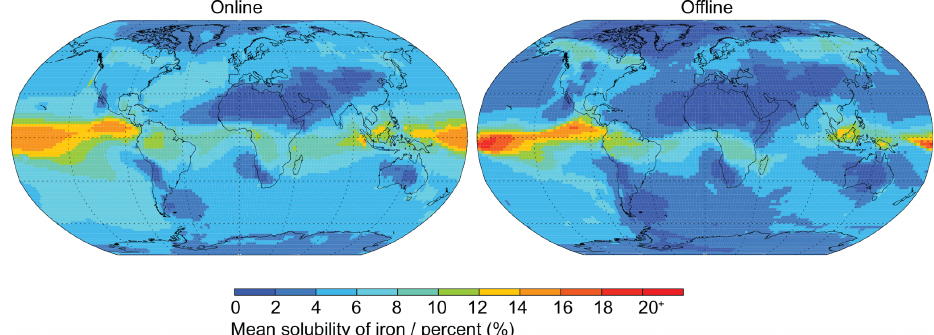
Figure 8. Mean solubility of iron when solubility is calculated at each 30min model time step (“online”) and when it is calculated from the post-processing of daily mean soluble and total iron concentration (“offline”). Table 7. Dust, fire, and anthropogenic combustion emissions of iron and relevant co-emitted aerosol emissions (to two significant figures). Multi-model emission range from the four global atmospheric iron models (including BAM-Fe) reported in Myriokefalitakis et al. (2018). Fine (sum of Aitken and accumulation modes) and coarse (coarse mode) mass emissions also given for dust, fire iron, and combustion iron. Annual mean emissions; Tga − 1 BAM-Fe MIMI Luo et al. (2008)